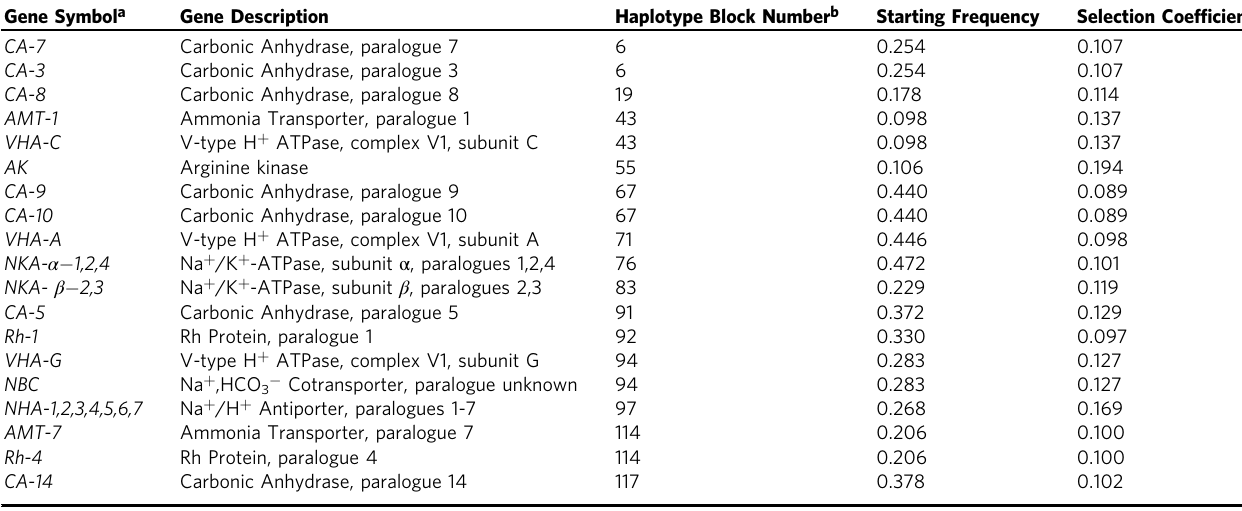
Table 1 Gene paralogues with putative ion-transporter and osmoregulatory function found on haplotype blocks showing signatures of selection to salinity decline in the laboratory evolution